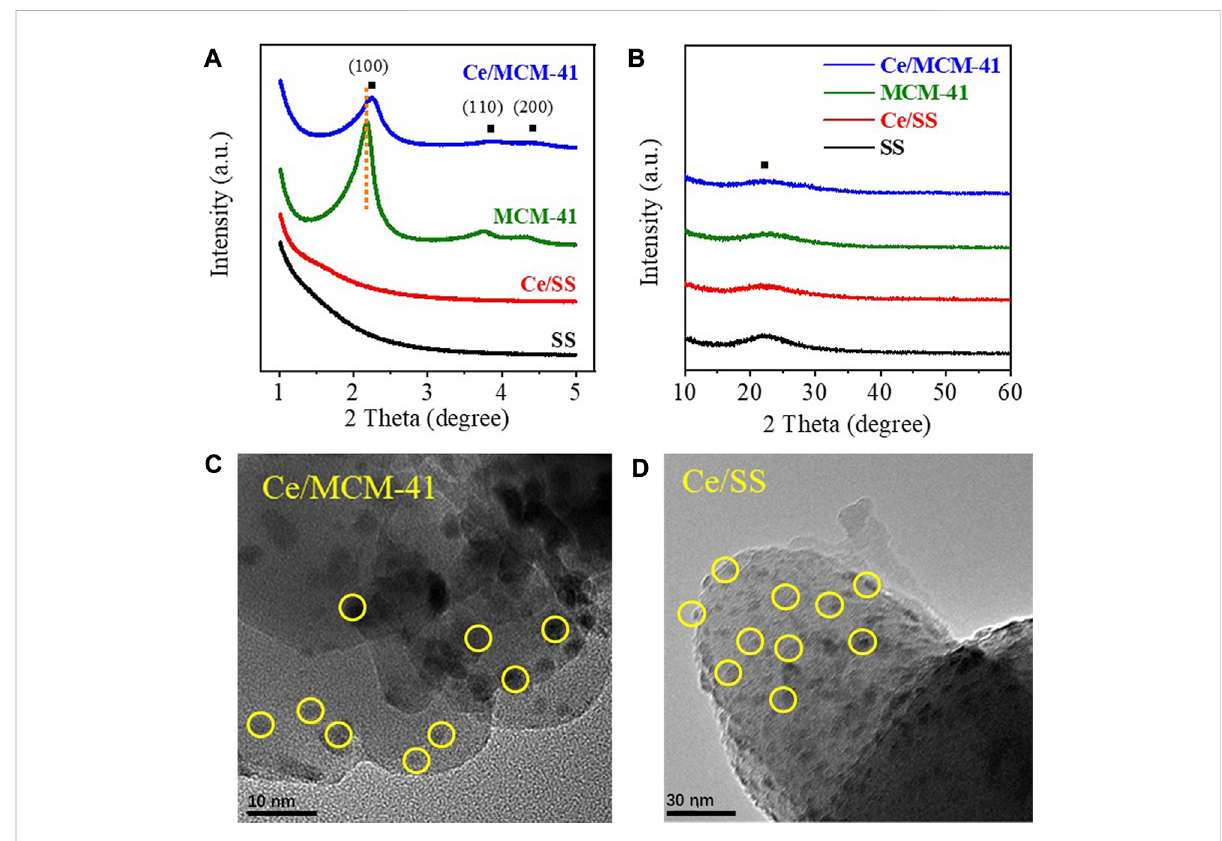
FIGURE 1 (A, B) XRD spectra of silica-based catalysts; (C) TEM image of Ce/MCM-41; (D) TEM image of Ce/SS.